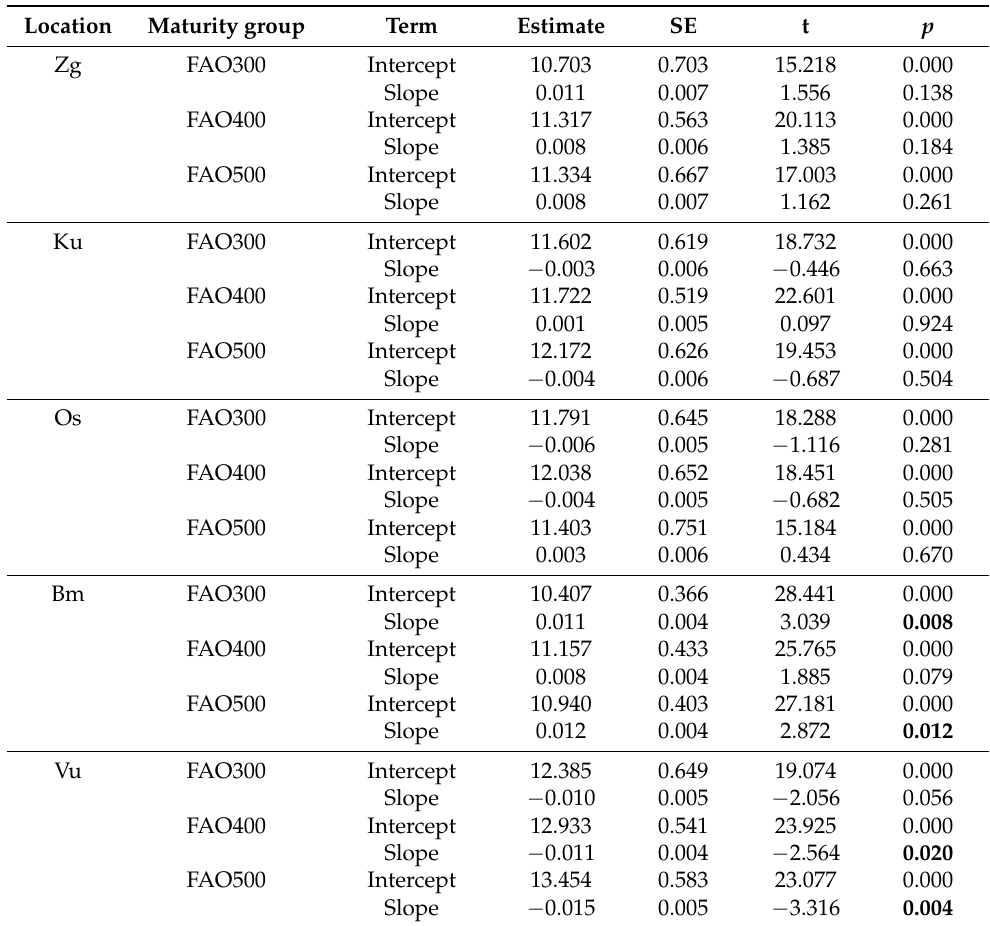
Table 2. Coefficients of regression of the L_BLUPs on SDD values estimated by a simple linear model. SE, t, and p designate the standard error, the t statistic and p -value of the fitted parameter, respectively. p -values lower than 0.05 are shown in bold.